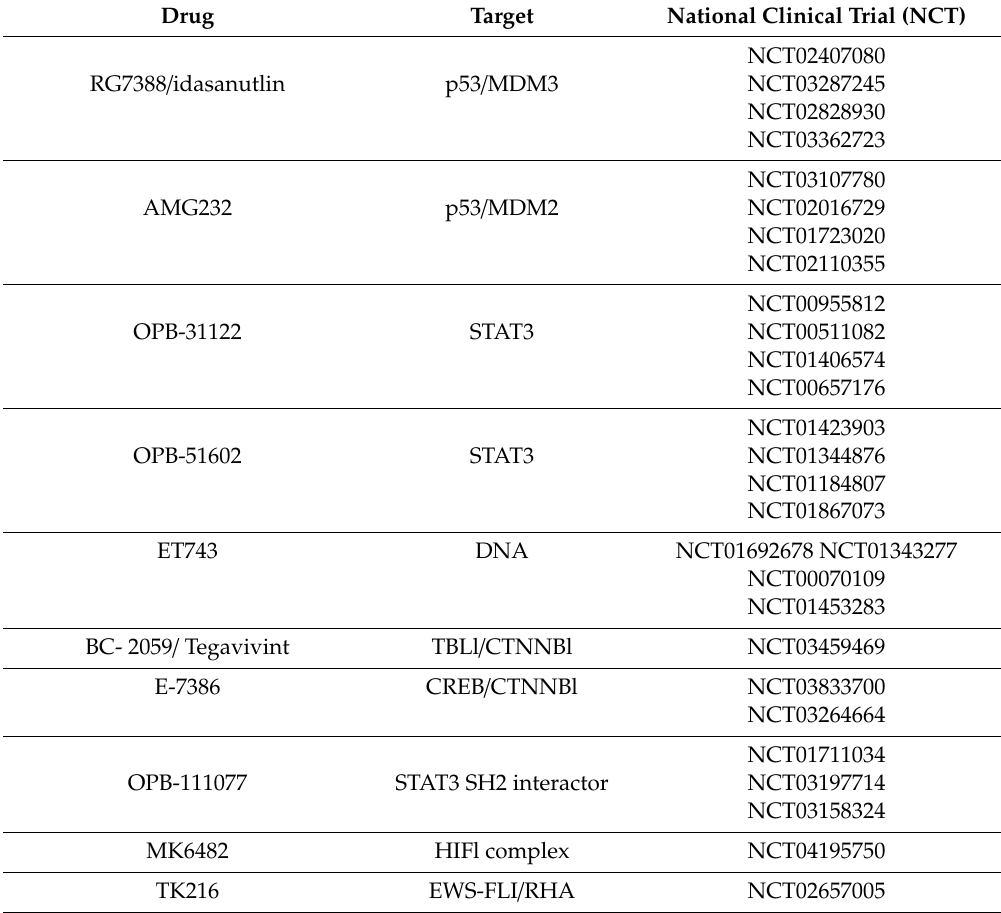
Table 1. Selected examples of drugs undergoing clinical trials for future transcription therapy. Respective targets and studies (National Clinical Trial (NCT) Identifier Numbers) are